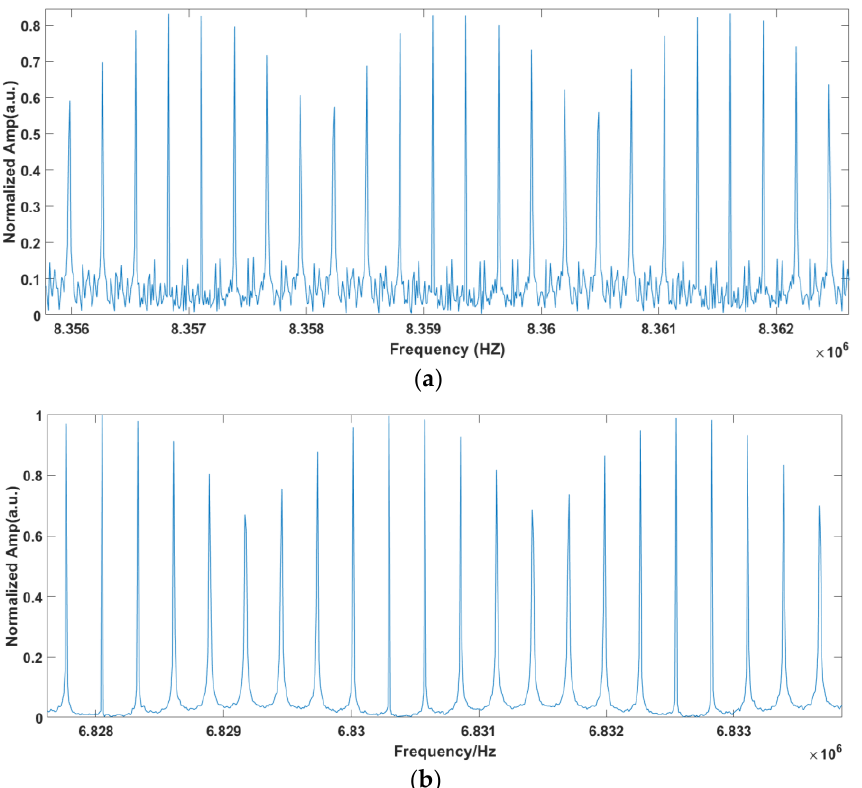
Figure 17. Comb component after the signal process in the experiment: ( a ): around the absorption peak, ( b ): around the peak of the whole spectrum.